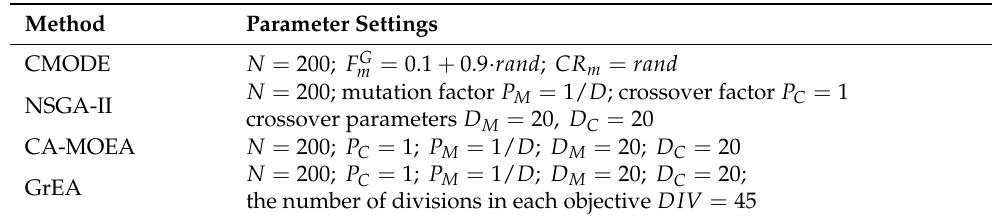
Table 3. Parameters settings of CMODE and other rivalries.